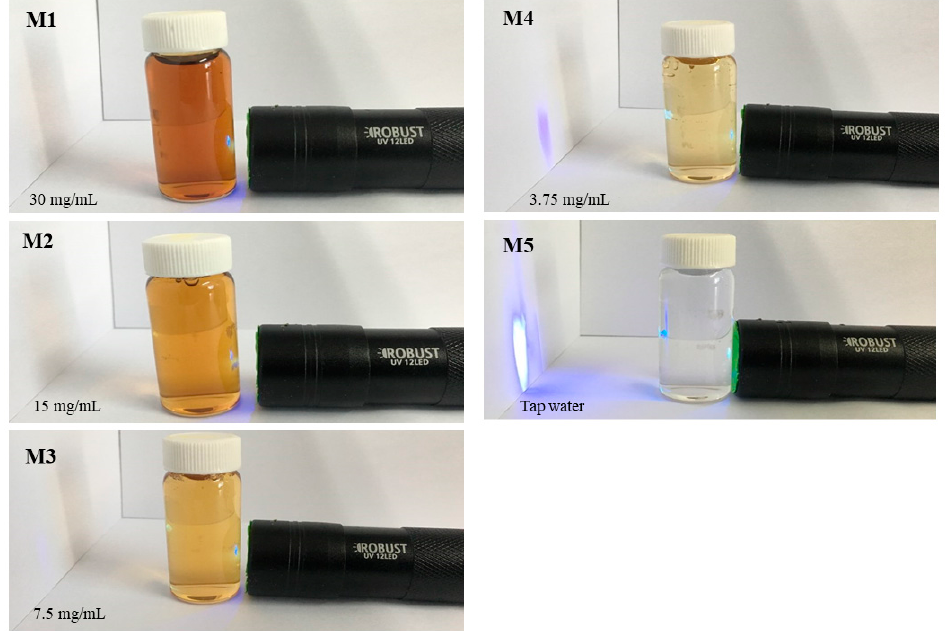
Figure 7. Results for blue light protection effects of MA-DME.